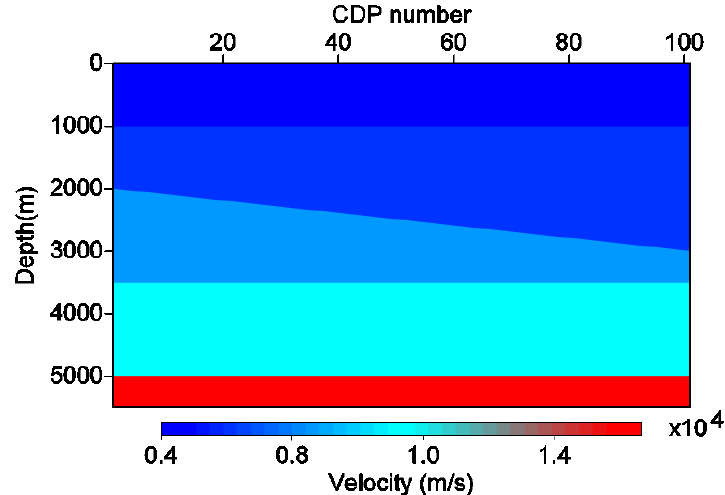
Figure 4. Theoretical model of interval velocity.